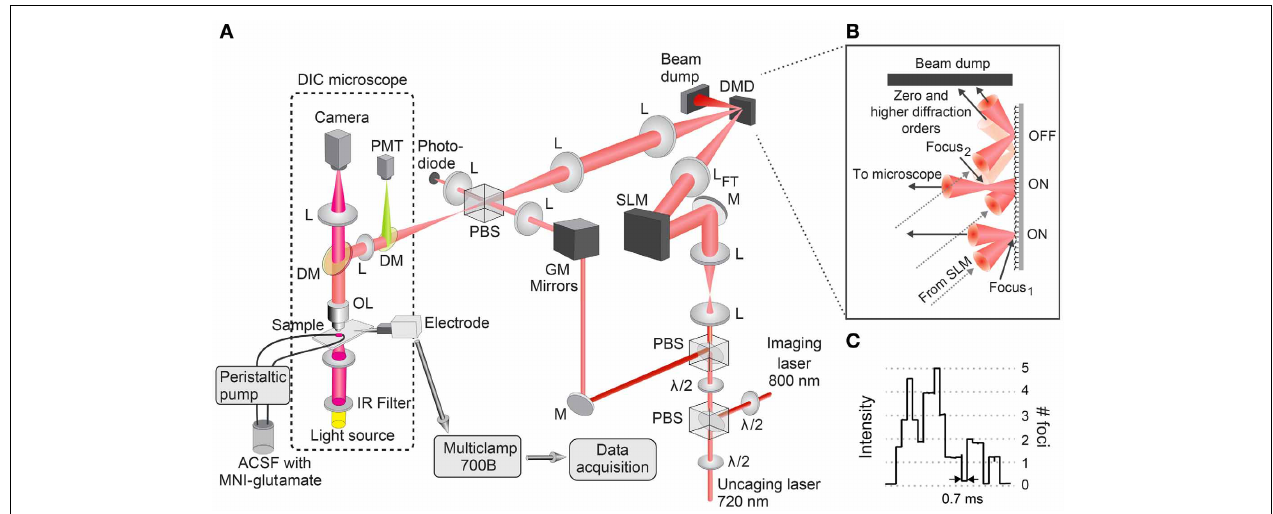
FIGURE 1 | Optical design of 4D holographic microscope. (A) Light from a laser tuned to 800nm is projected through two polarizing beam splitters (PBS) onto two galvanometer (GM) scanning mirrors that scan the excitation beam across the sample for imaging. Fluorescence from the sample is collected by a photomultiplier tube (PMT). Light from another laser tuned to 720nm is expanded, projected onto a spatial light modulator (SLM), focused onto a digital micro-mirror device (DMD) and imaged onto the sample. The SLM is encoded with a phase hologram that generates a multi-focal excitation pattern from the incident laser beam. The DMD acts as a spatial light switch allowing independent switching of the individual foci. The resulting spatio-temporal excitation pattern at the sample plane is used for uncaging